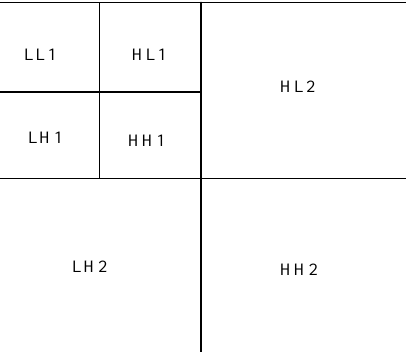
Figure 8. 2-Level wavelet decomposition of an